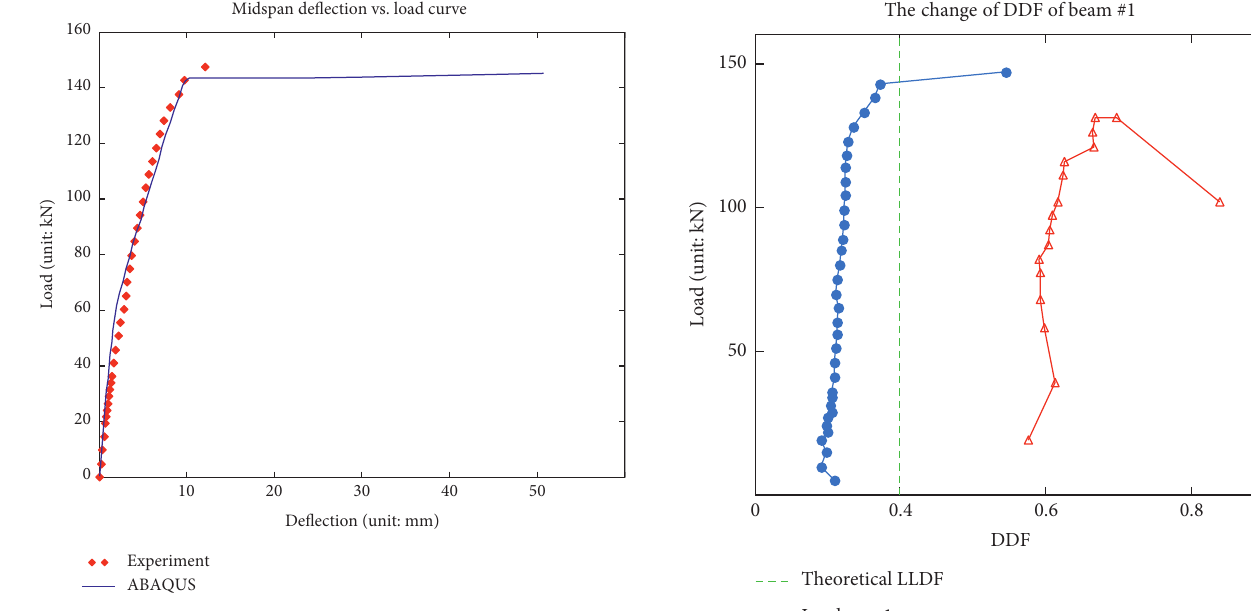
Figure 13: Response of the exterior beam of the model bridge subjected to a concentrated load.